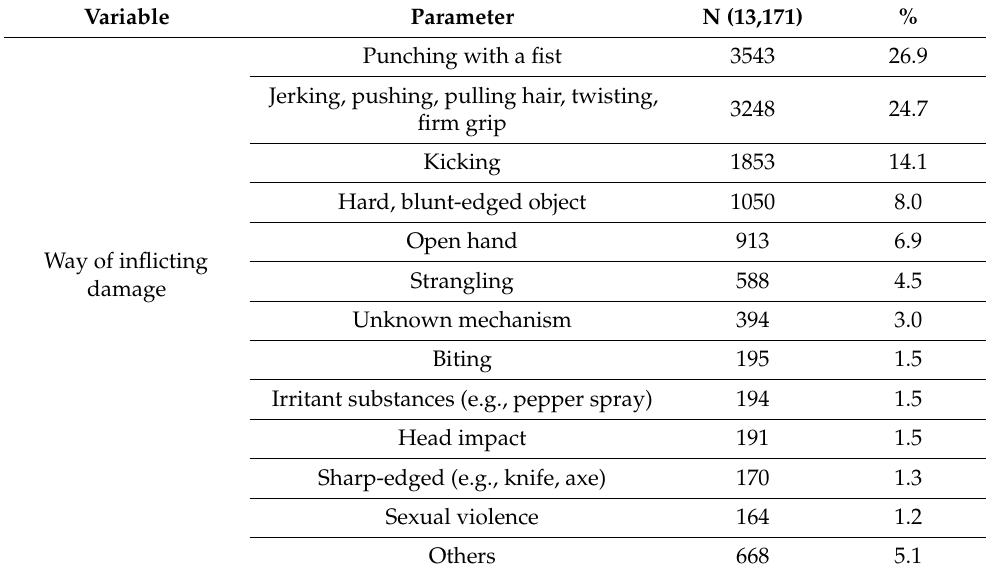
Table 9. Way of inflicting damage.